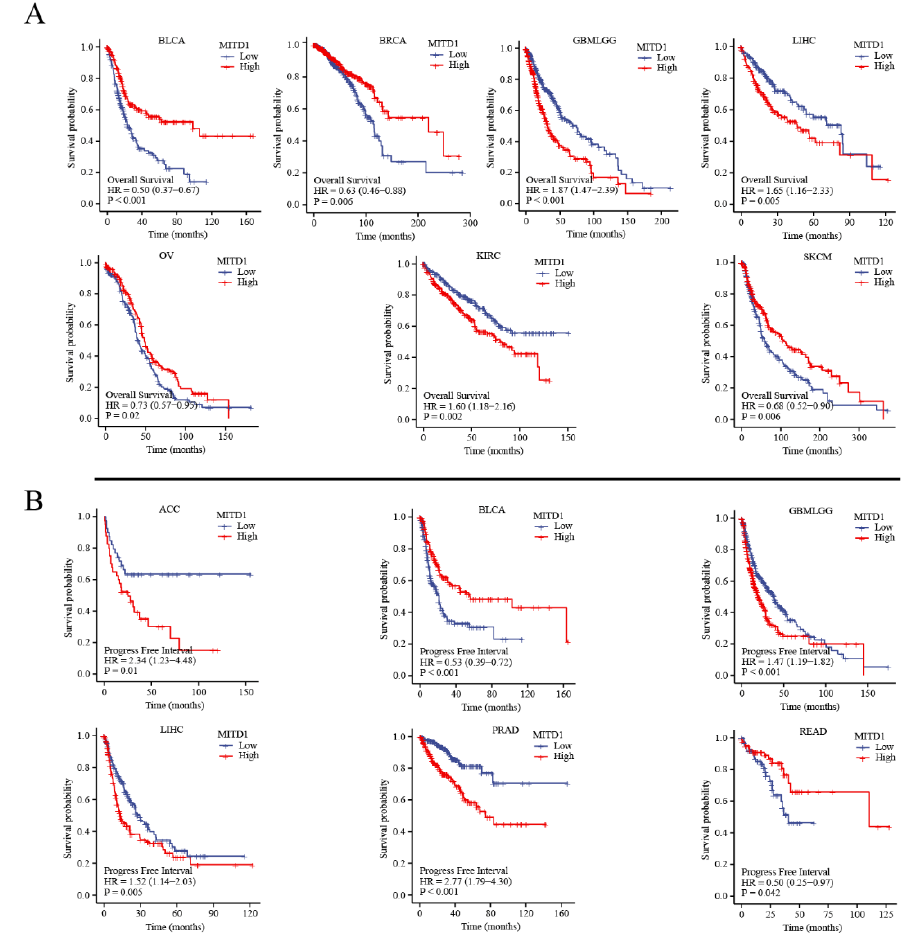
Figure 7. Correlation between MITD1 expression and survival prognosis of cancers in TCGA. ( A ) The correlation between MITD1 expression and overall survival of different cancers. ( B ) The correlation between MITD1 expression and progress free interval of different cancers.